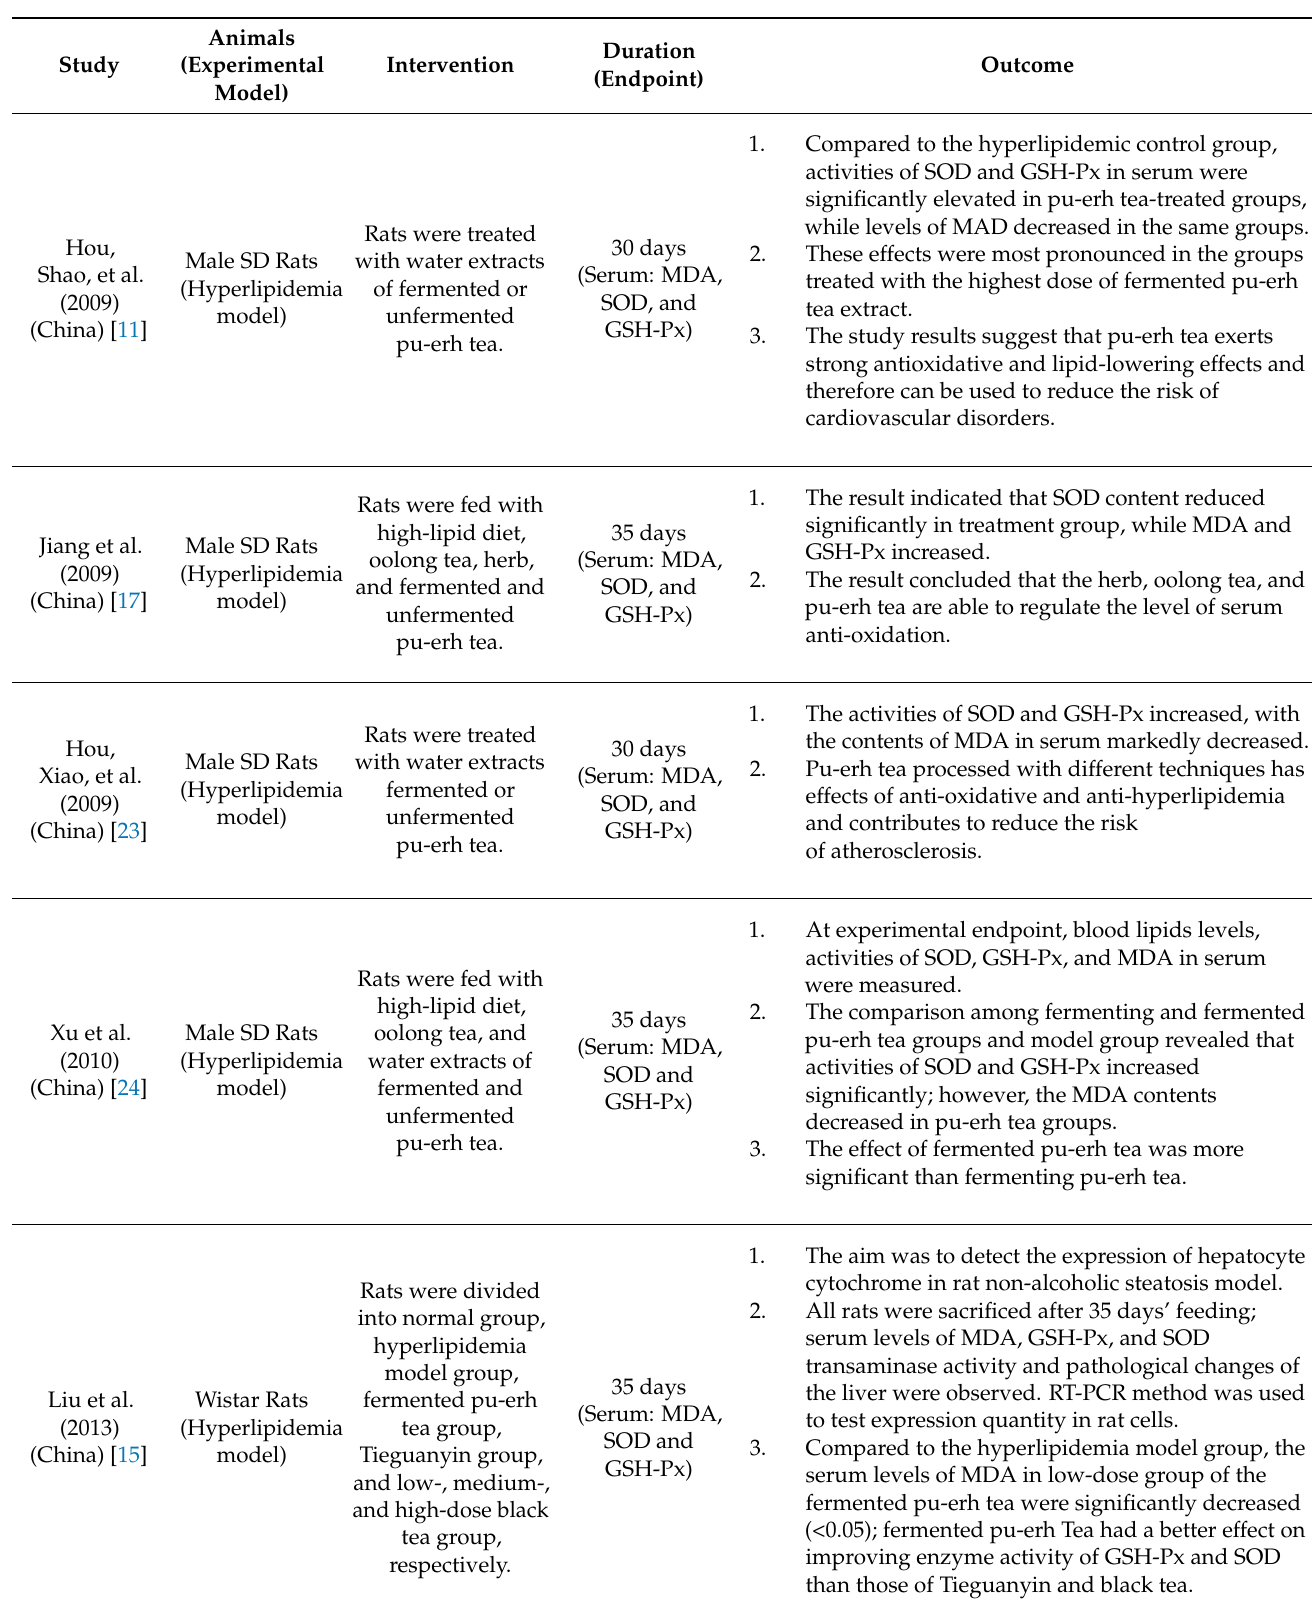
Table 1. System review of pu-erh tea anti-oxidative effect in